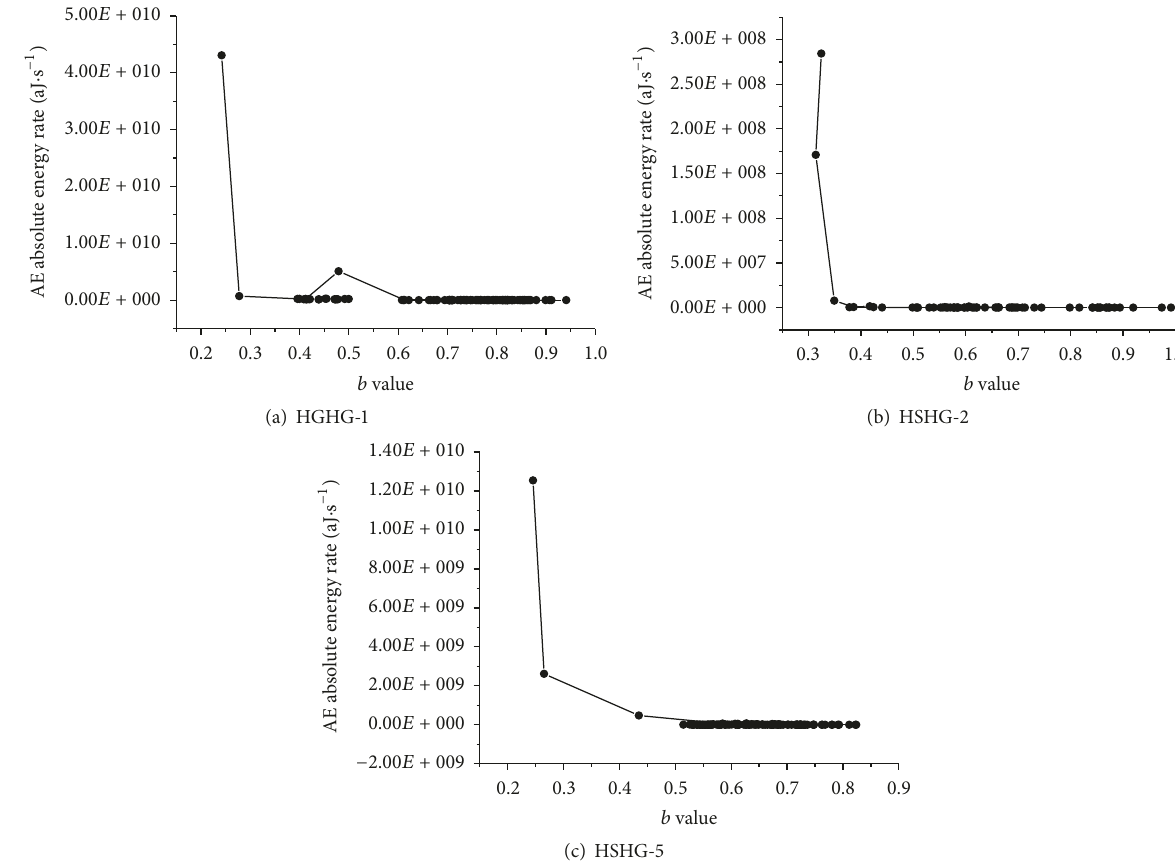
Figure 4: Correlation diagram between AE 𝑏 value and absolute energy in the granite fracture